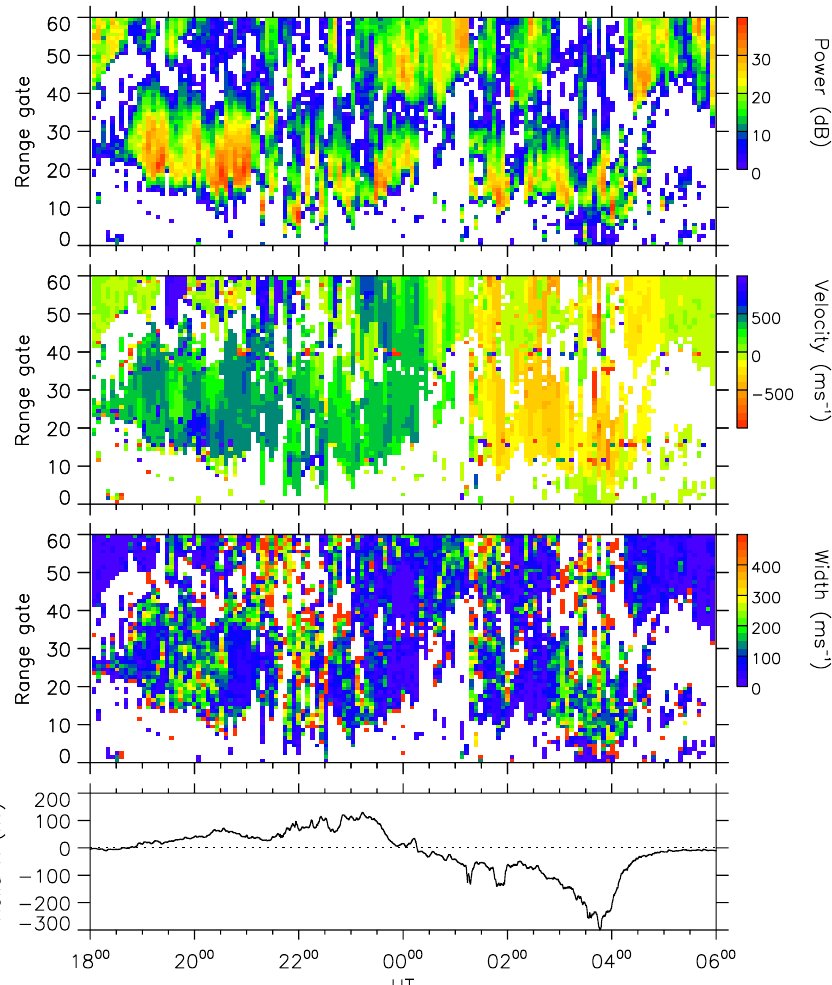
Fig. 2. (Top panels) Range-time-parameter plots of backscatter power, Doppler shift, and spectral width, from beam 15, the most easterly- pointing beam of the radar. Positive Doppler shifts indicate motion towards the radar. (Bottom panel) H -component magnetogram from the SAMNET Hella magnetometer, co-located with the Iceland East